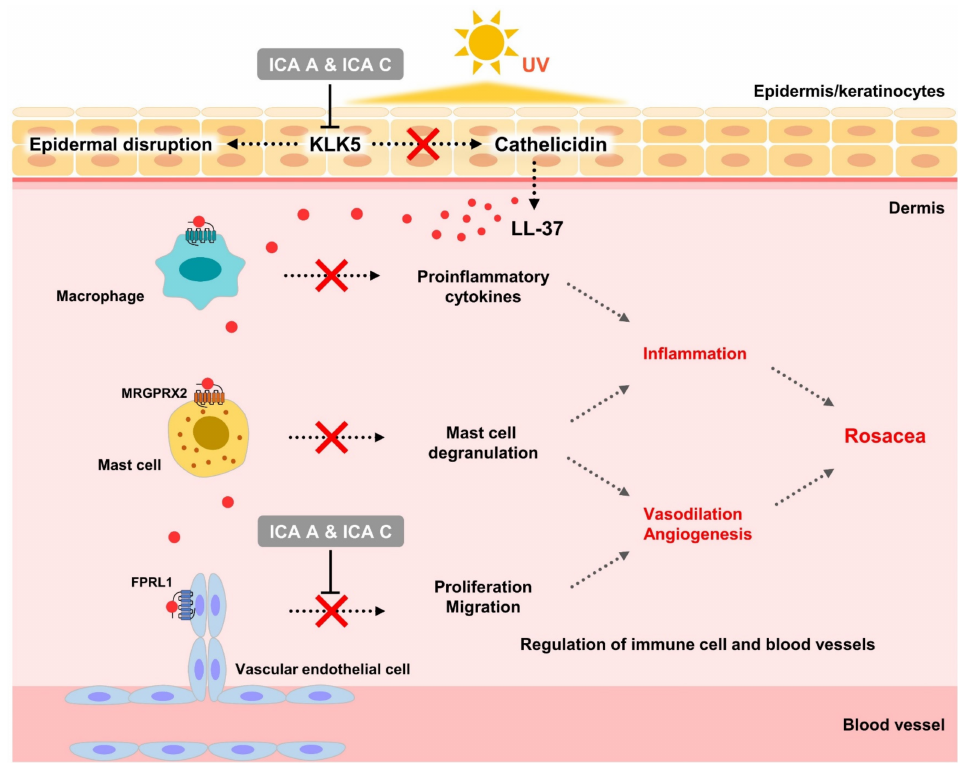
Figure 7. Mechanism of action of isochlorogenic acids A and C in rosacea. ICA A, isochlorogenic acid A; ICA C, isochlorogenic acid